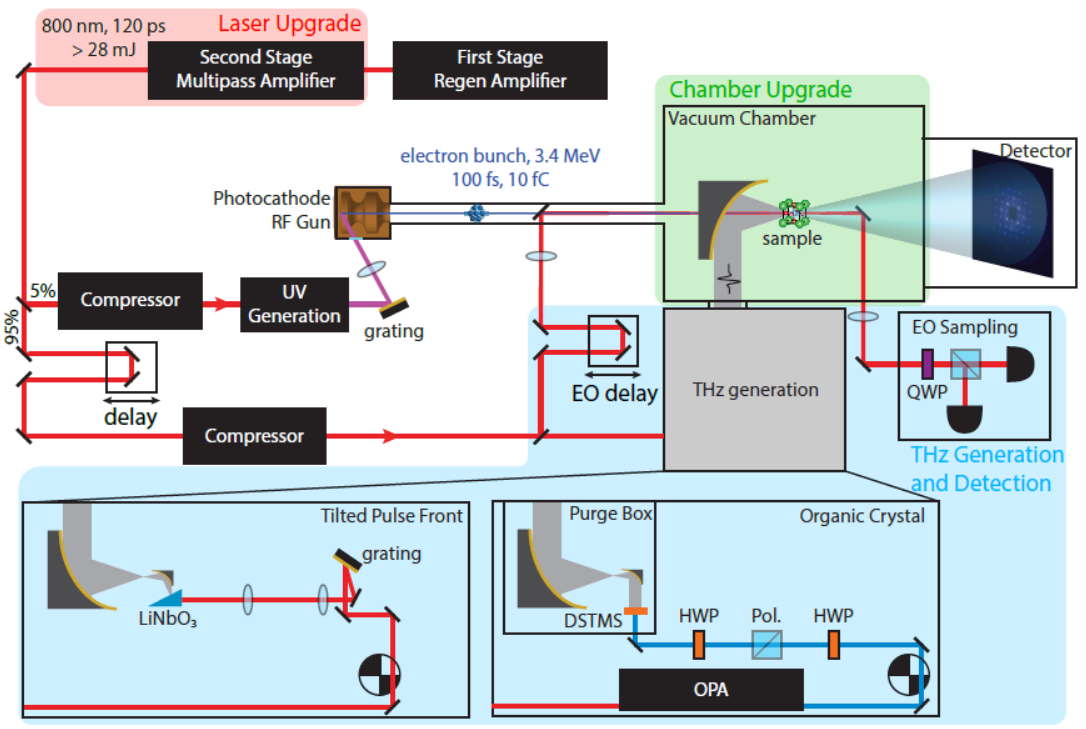
Figure 18. Schematic illustration of optical setup used in the ultrafast TR electron diffraction used at SLAC. The setup is powered with the Ti:sapphire regenerative amplifier, which beam is split to produce both UV pulses by third harmonic generation (later used to generate fs electron bunches), as well as laser-light pump beam and auxiliary optical lines for THz generation. Figure reproduced with permission from Ofori-Okai et al. [149]. Copyright (2018) IOP.